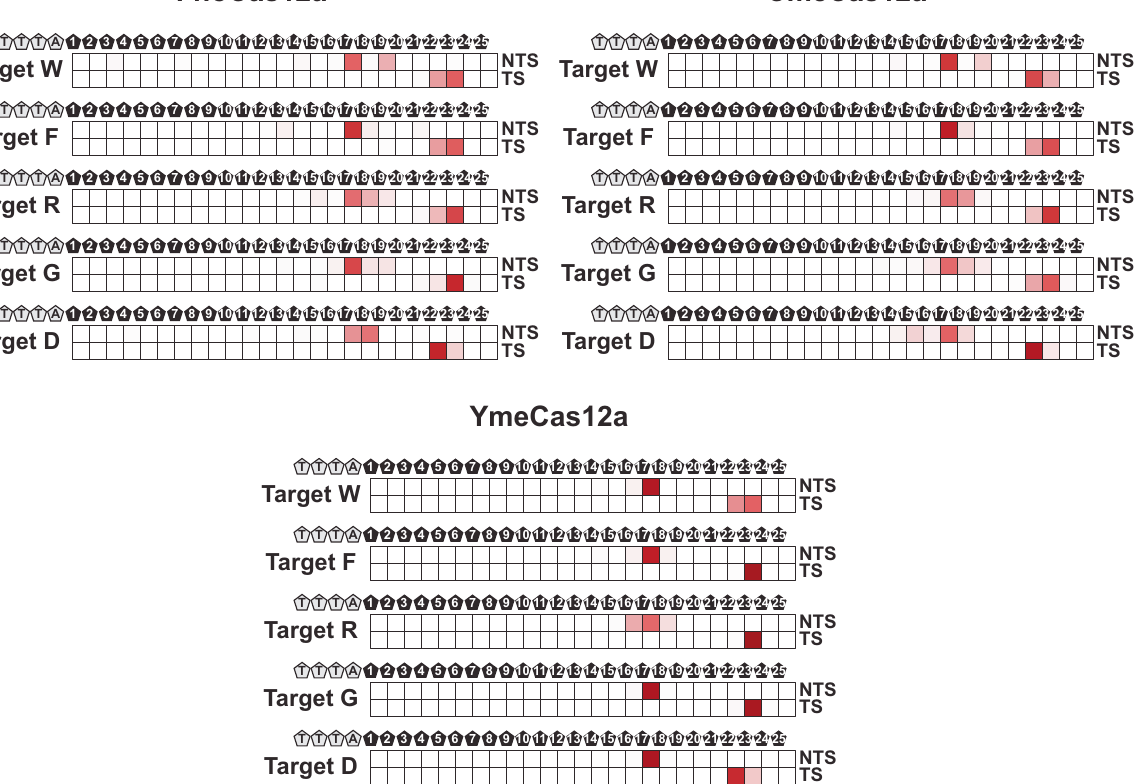
not responsible for the activity (Supplementary Figure S12). Accumulation of fl uorescence signal using an RNA reporter was ~10-fold slower than when using a DNA reporter (Supplemen- tary Figure S11B), demonstrating that while DNA is cleaved more rapidly than RNA it is possible for activated Cas12a proteins to cleave RNA in trans .